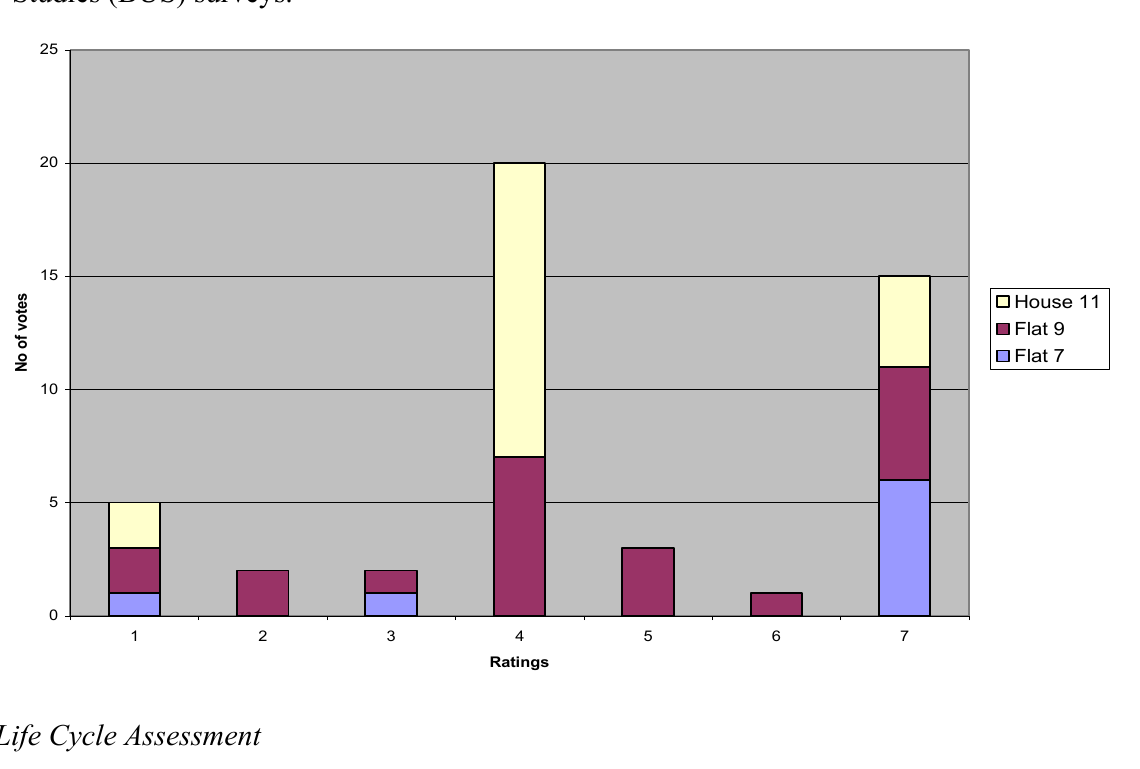
Figure 4. Cumulative votes cast in response to different dimensions of the Building Use Studies (BUS)